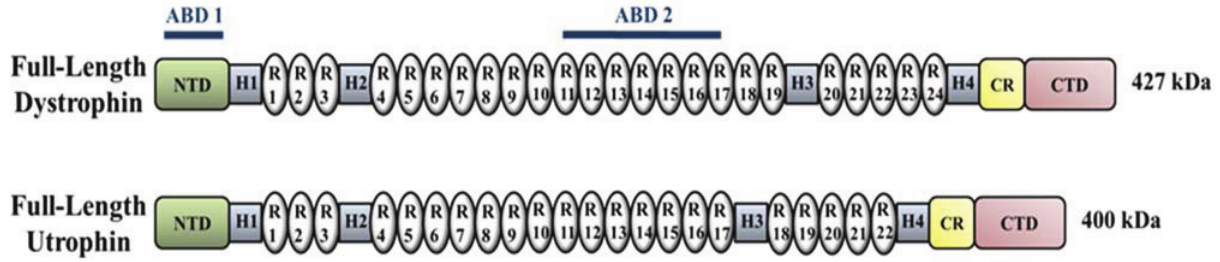
Figure 3. Structural domains of the dystrophin and utrophin proteins. The dystrophin and the utrophin proteins share a similar organization and binding affinity for other members of the DAPC. Both proteins contain an N-terminal domain (NTD) that interacts with actin, also known as actin-binding domain 1 (ABD1), a central region composed of different spectrin-like repeats (R1–R24) interspersed by four hinge regions (H1–H4), a cysteine-rich (CR) domain that binds (cid:2)-dystroglycan and a C-terminal domain (CTD) that interacts with (cid:2)-dystrobrevin and the syntrophins. The major difference between the two proteins is represented by the presence of a second actin-binding domain (ABD2) present in dystrophin, but absent in